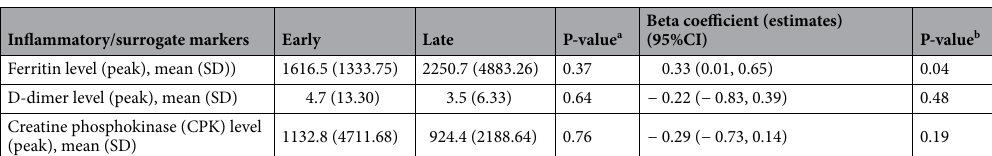
Table 3. Regression analysis of peak inflammatory/surrogate markers after propensity score. a Wilcoxon rank sum test is used to calculate the P-value. b Propensity score matched used based on patient’s SOFA score, MV within 24 h of ICU admission, proning position, and early use of Tocilizumab within 24 h of ICU admission.